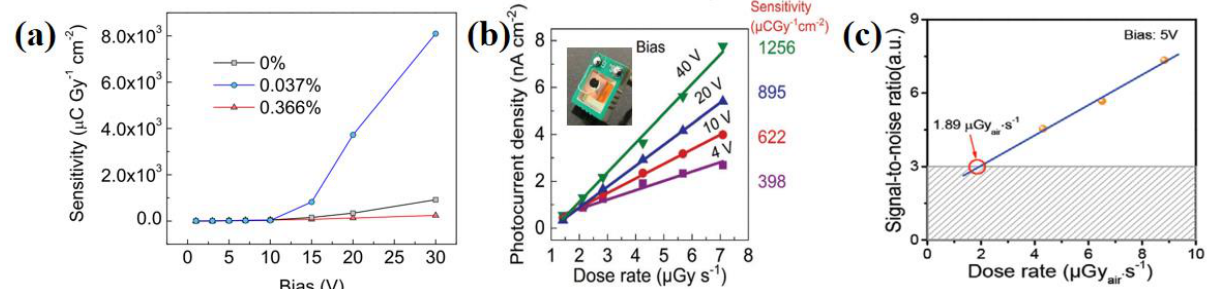
Figure 7. ( a ) Sensitivity of Cs (1-x) Rb x PbBr 3 single-crystal X-ray detector with different percentages of Rb doping [49]. ( b ) CsPbBr 3 single crystal via solution growth [50]. ( c ) LOD of CsPbBr 3 perovskite single crystal via humidity-controlled solvent evaporation at room temperature